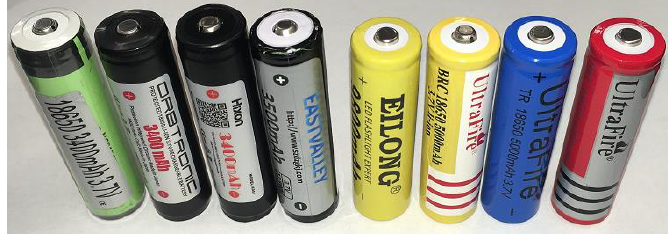
Figure 1. Evaluated commercially available protected 18650 cells purchased from Amazon.com. Arrangement of cells shown are: Panasonic, Orbtronic, Hixon, EastValley, Eilong, UF-Yellow, UF-Blue, and UF-Red.